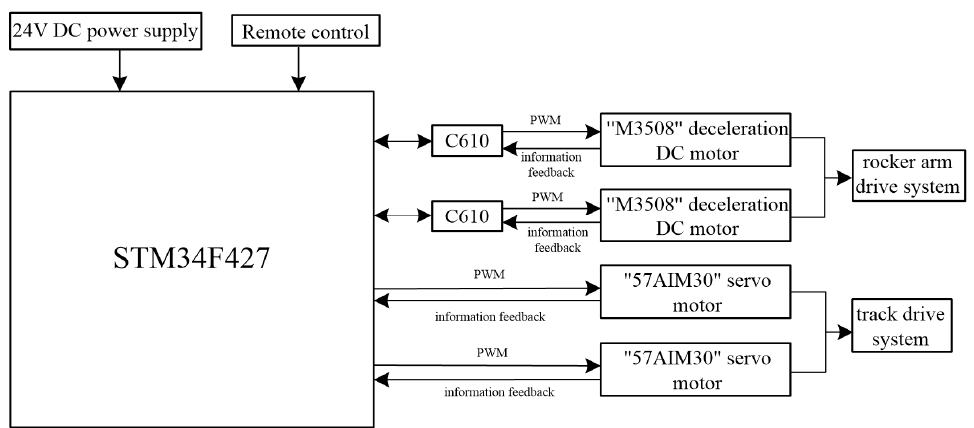
Figure 2. The system control diagram.